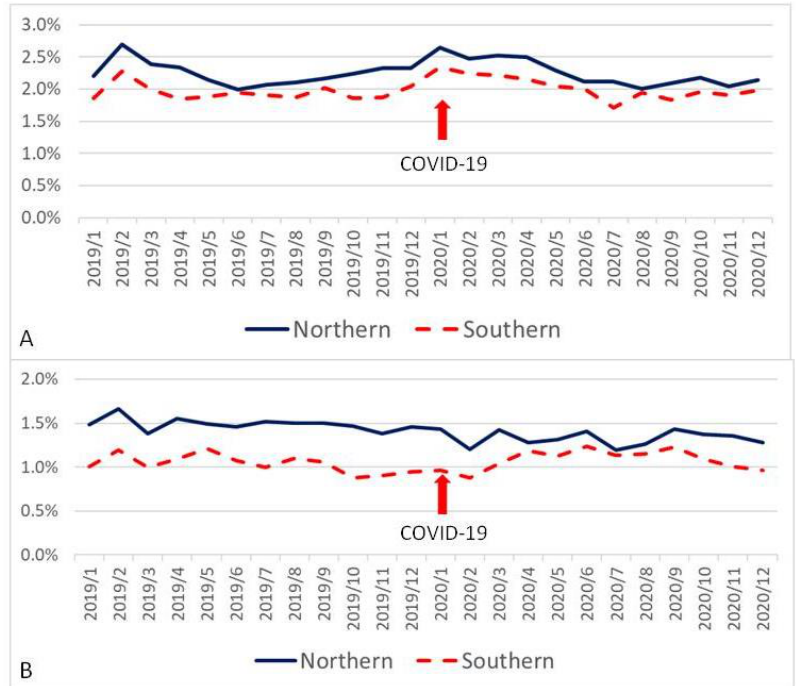
Figure 2. Control chart of hospitalization-related quality indicators based on the location of medical centers (red arrow represents outbreak of COVID-19). ( A ): In-hospital mortality rate excluding critical discharge against medical advice. ( B ): Unscheduled returns within 14 days for the hospitalized patients.